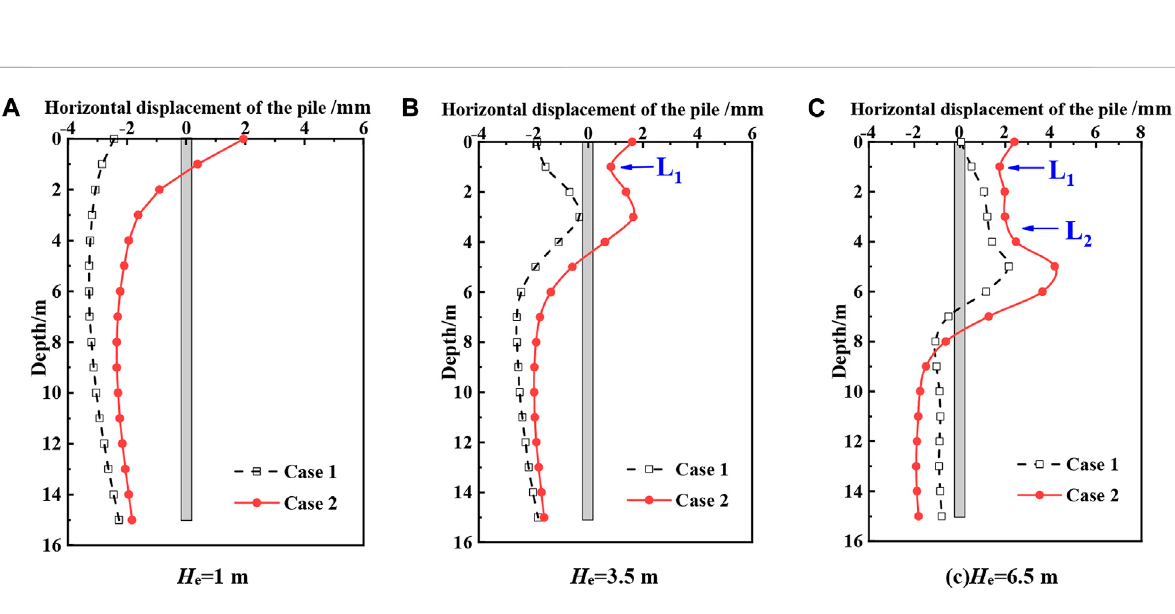
measured results are basically consistent, especially at the peak of deformation at the pit bottom. There is a certain deviation between the measured and calculated values of horizontal displacement of the piles because the inclinometers were installed in the ground behind the steel-sheet piles. Figure 15 shows that the calculated value of surface settlement is soundly consistent with the measured results on site, and the surface settlement is in a “ groove type. ” The actual settlement value near